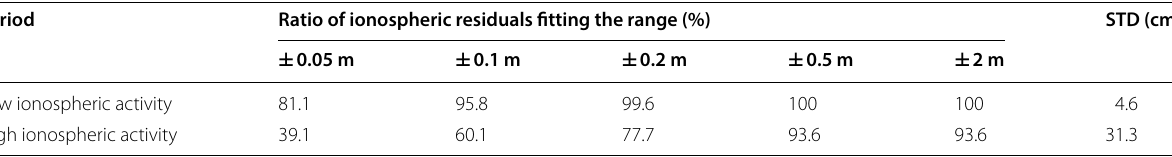
0.05 m 0.1 m 0.2 m 0.5 m 2 m ± ± ± ± ±